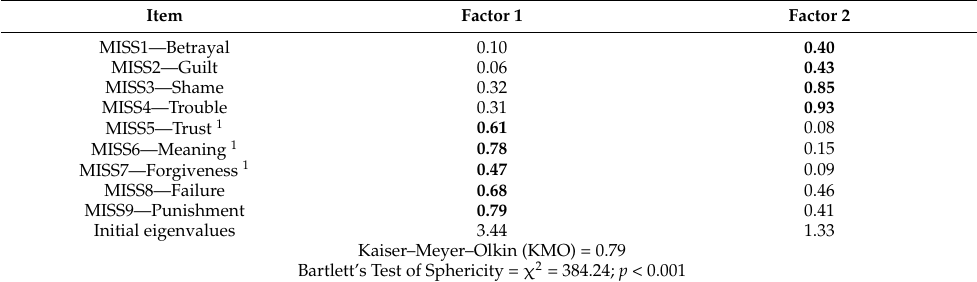
Table 5. Structural matrix factor loadings of principal axis factoring analysis with Promax rotation for 9 items of G-MISS-HP ( n 1 = 78; first half of the